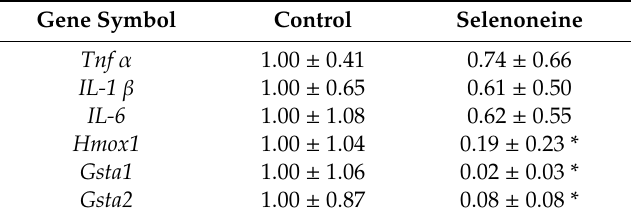
Table 2. Hepatic mRNA levels of disorder-related genes.